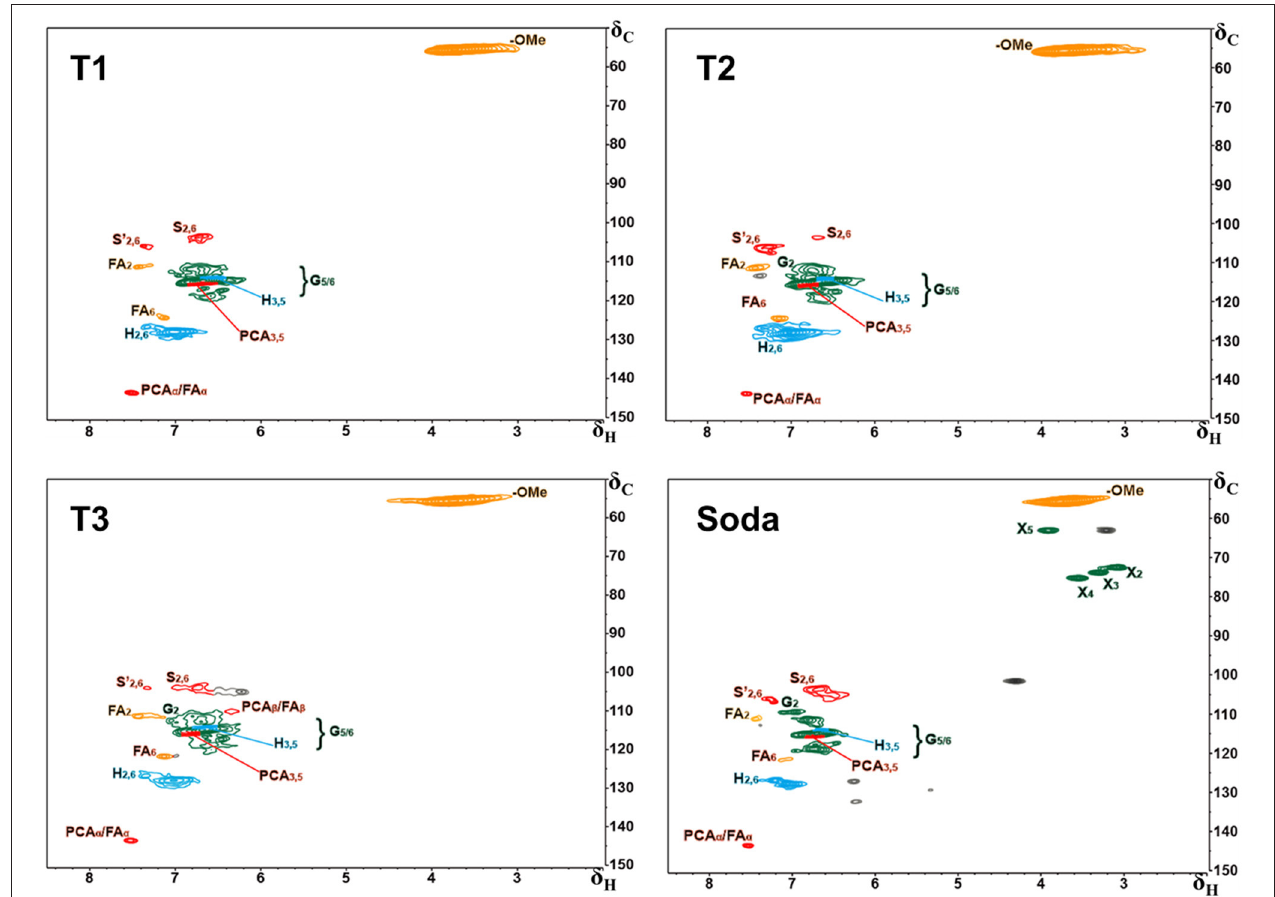
FIGURE 3 | 2D-HSQC-NMR spectra of the extracted lignin